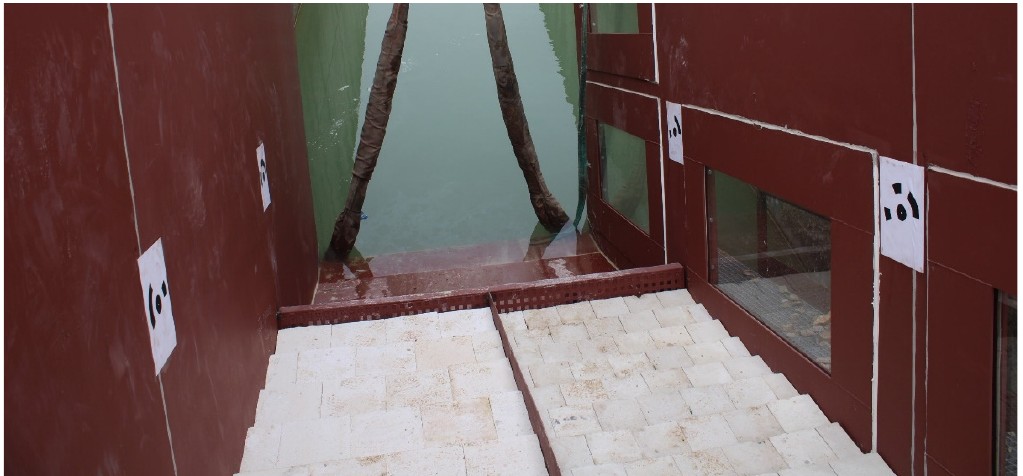
Figure 23. Detail of the perforated metal plate, where the downstream row of the WSB was sup- ported.